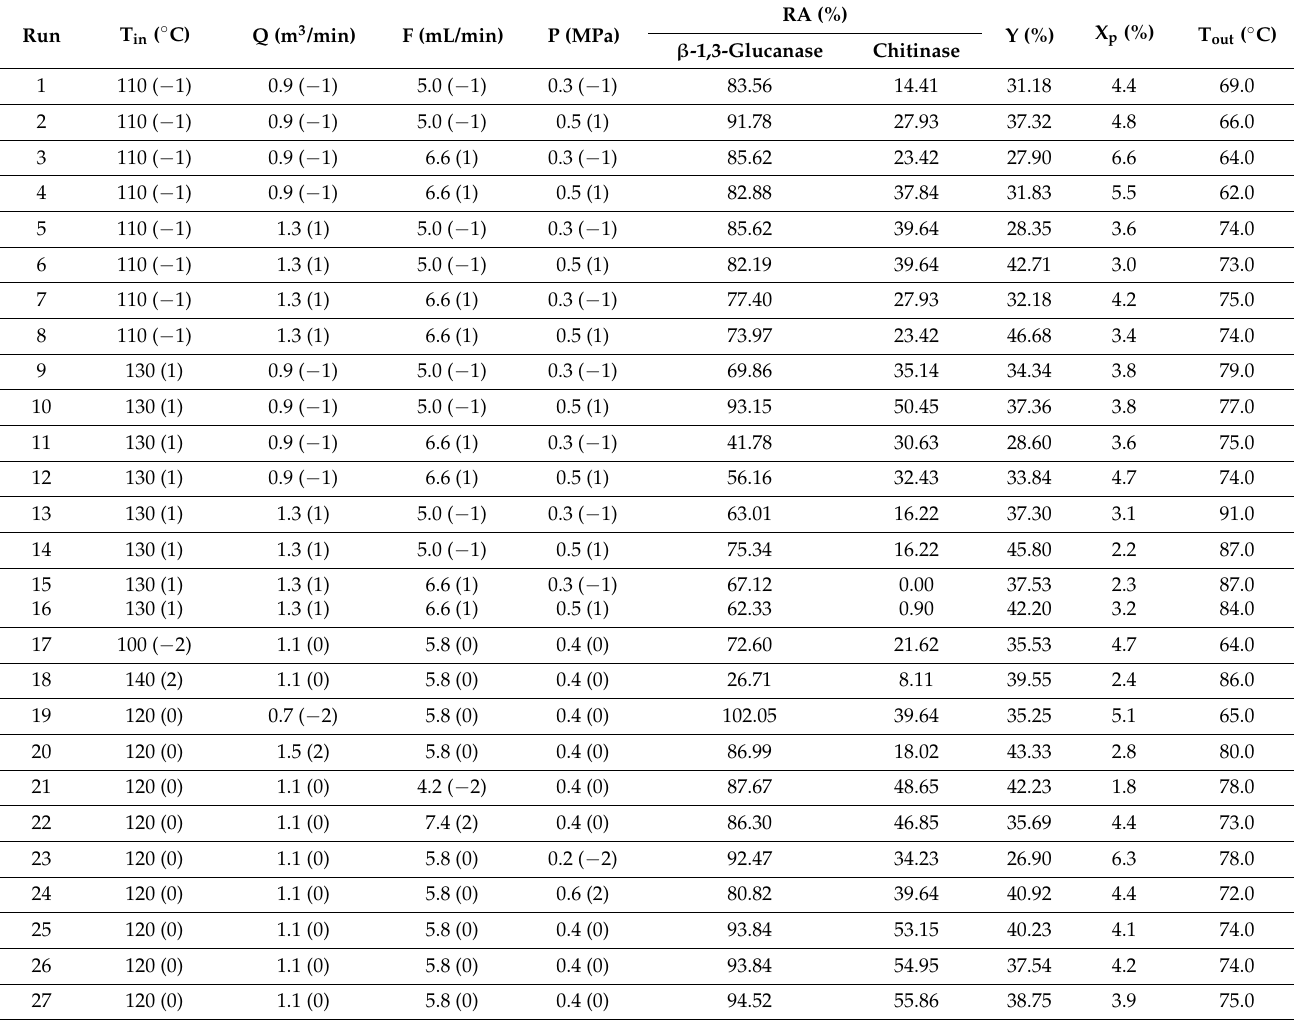
Table 4. Experimental design and results obtained in the spray drying